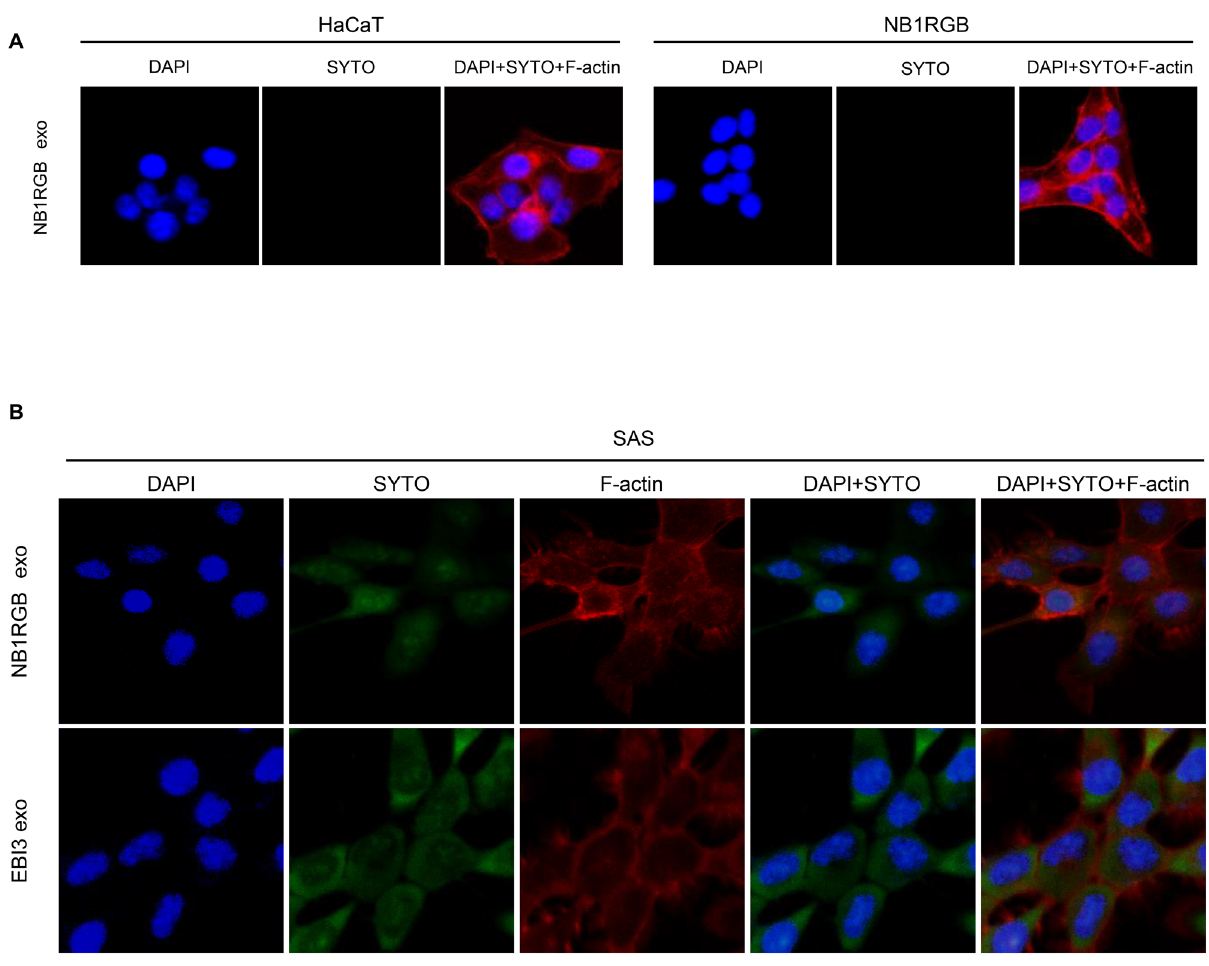
Figure 2. Uptake of visualized exosomes under a confocal laser scanning microscope. ( A ) Exosomes from NB1RGB cells were stained with the SYTO RNA Select Reagent (SYTO). HaCaT cells and NB1RGB cells were treated with exosomes derived from NB1RGB cells (NB1RGB exo). Note that immuno-reaction for SYTO (in green) was not evident in these cells. ( B ) NB1RGB exo or EBI3 exo were stained with SYTO. Note that accumulated SYTO staining was detected in EBI3